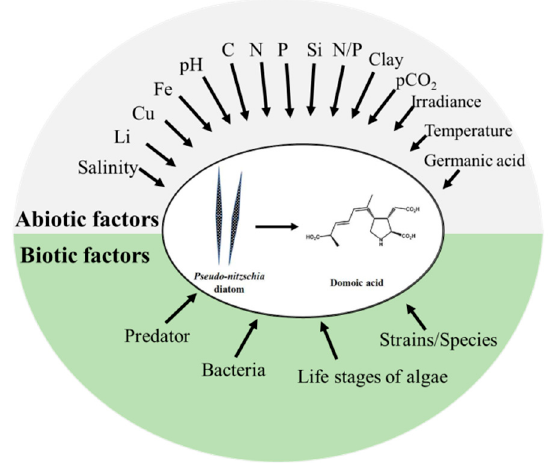
Figure 2. Factors affecting the production of DA.